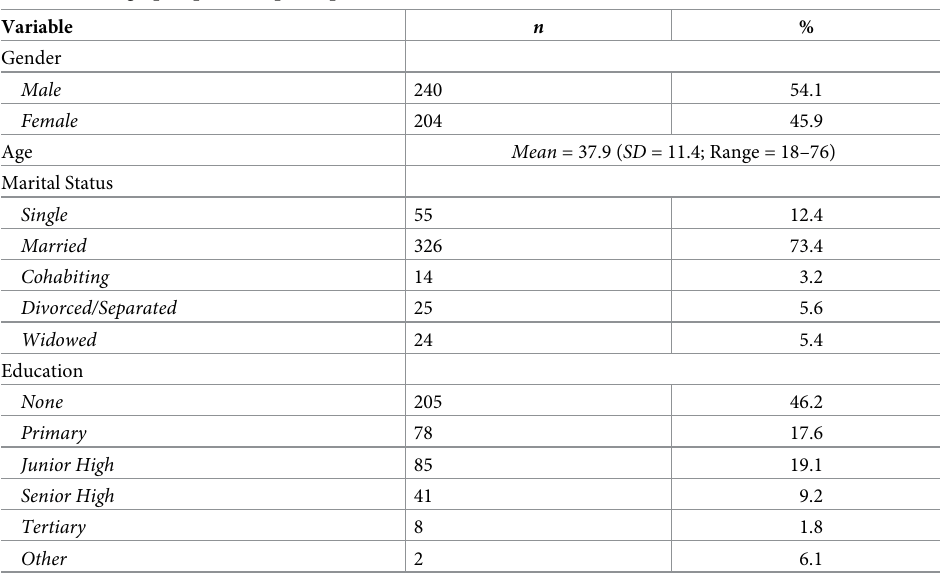
Table 1. Demographic profile of